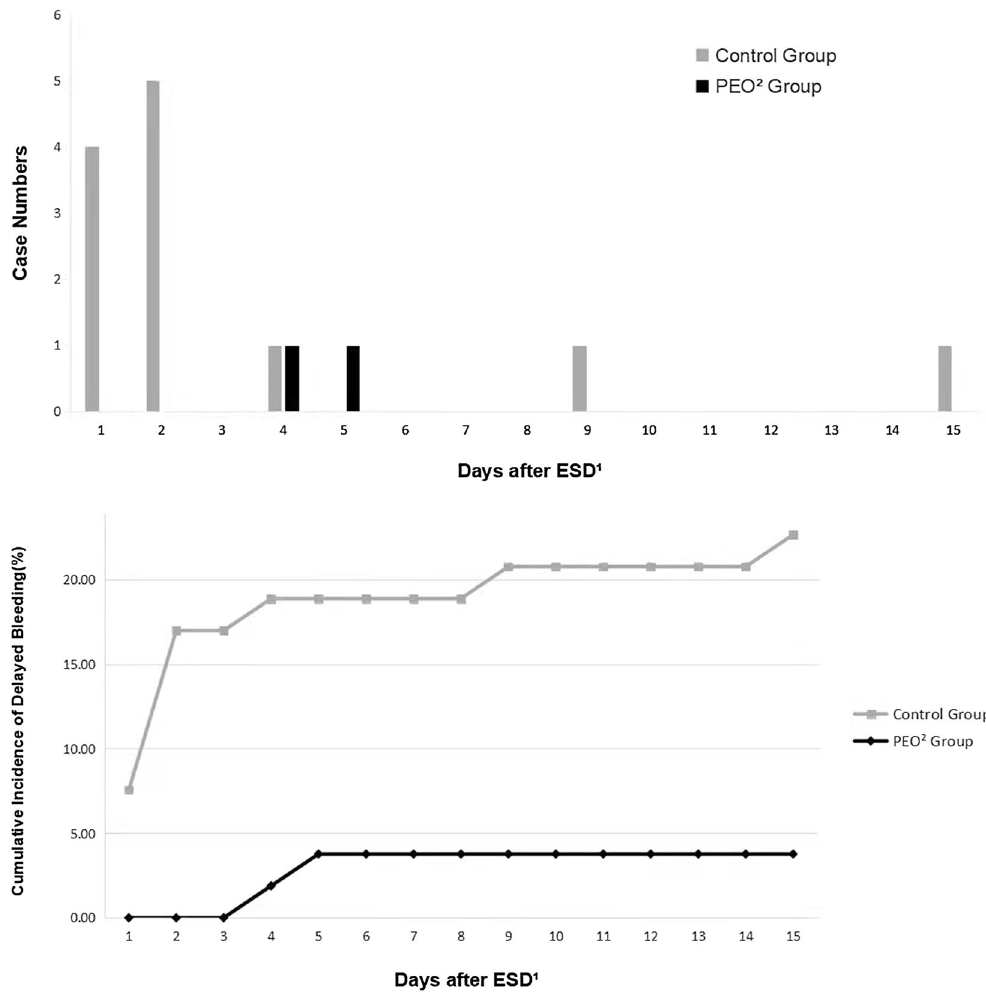
Figure 4. Case number and cumulative incidence of delayed bleeding after propensity score matching. 1 ESD endoscopic submucosal dissection, 2 PEO polyethylene oxide.